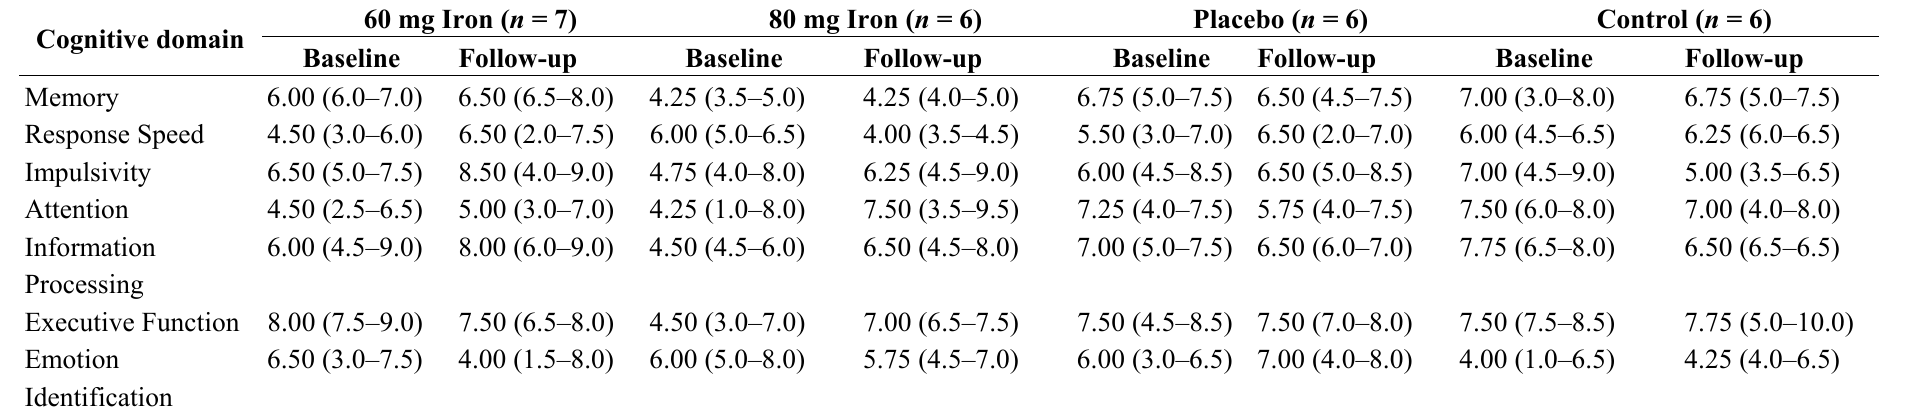
Table 1. Median (and interquartile range) for each cognitive domain score from a pilot double-blinded, placebo-controlled randomised control trial of the effects of iron supplementation (60 or 80 mg iron or placebo for 16 weeks) on the cognitive function of iron-deficient (ferritin < 20 μ g/L, haemoglobin ≥ 120 g/L) and iron-sufficient (ferritin ≥ 20 μ g/L, haemoglobin ≥ 120 g/L) women (18–35 years), at baseline and follow-up by group (60 or 80 mg iron, iron-deficient placebo or iron-sufficient